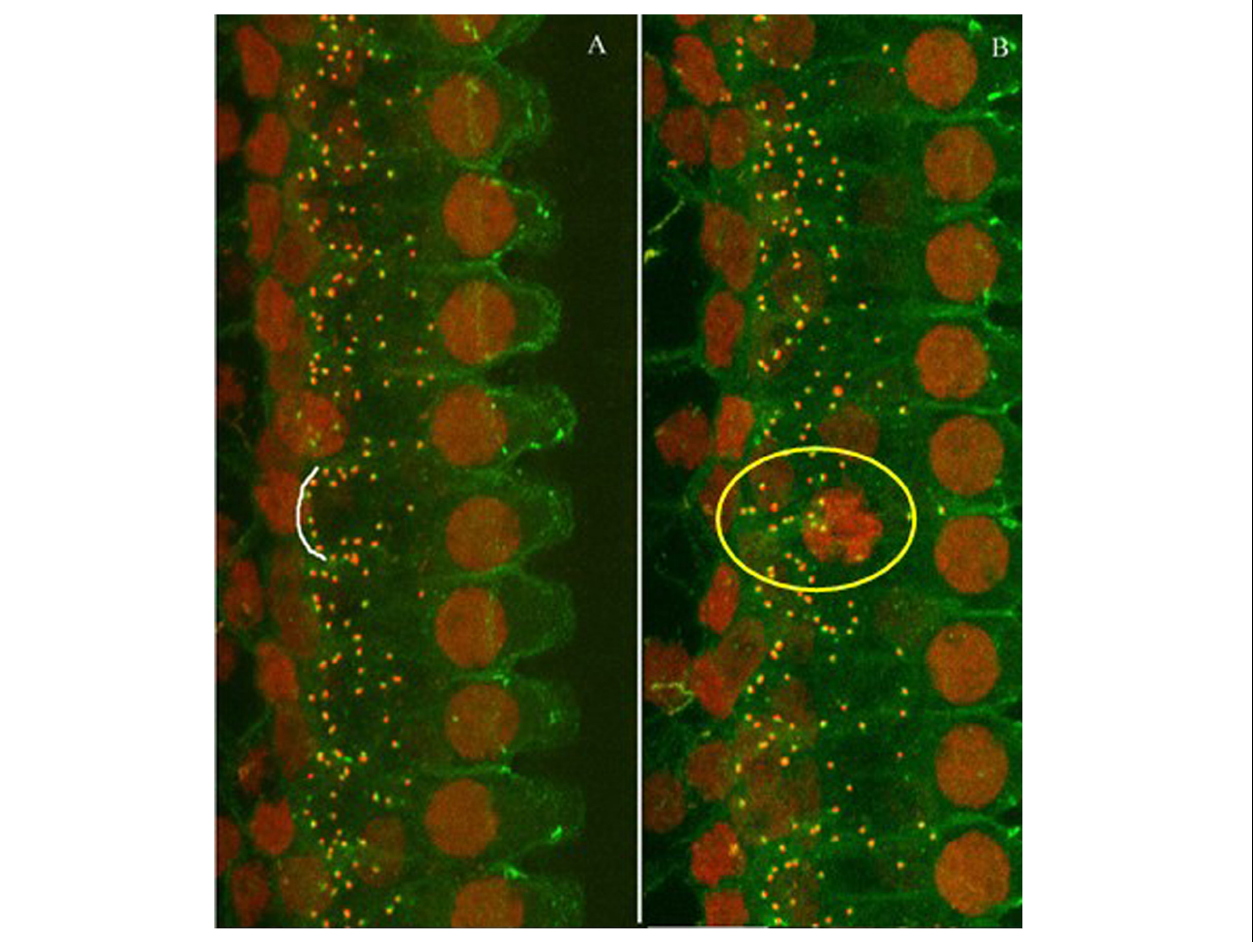
FIGURE 2 | Representative images of immunostaining against CtBP2 (red dots) and PSD (green dots). (A) Control animal. (B) Noise-exposed animal (one-month post-noise exposure). The images were taken from the high frequency region of the cochlea. The distribution of the puncta was mostly alone the bottom of the IHCs as (the white arc), but less organized in the noise-exposed cochlea (see the puncta in the yellow circle).